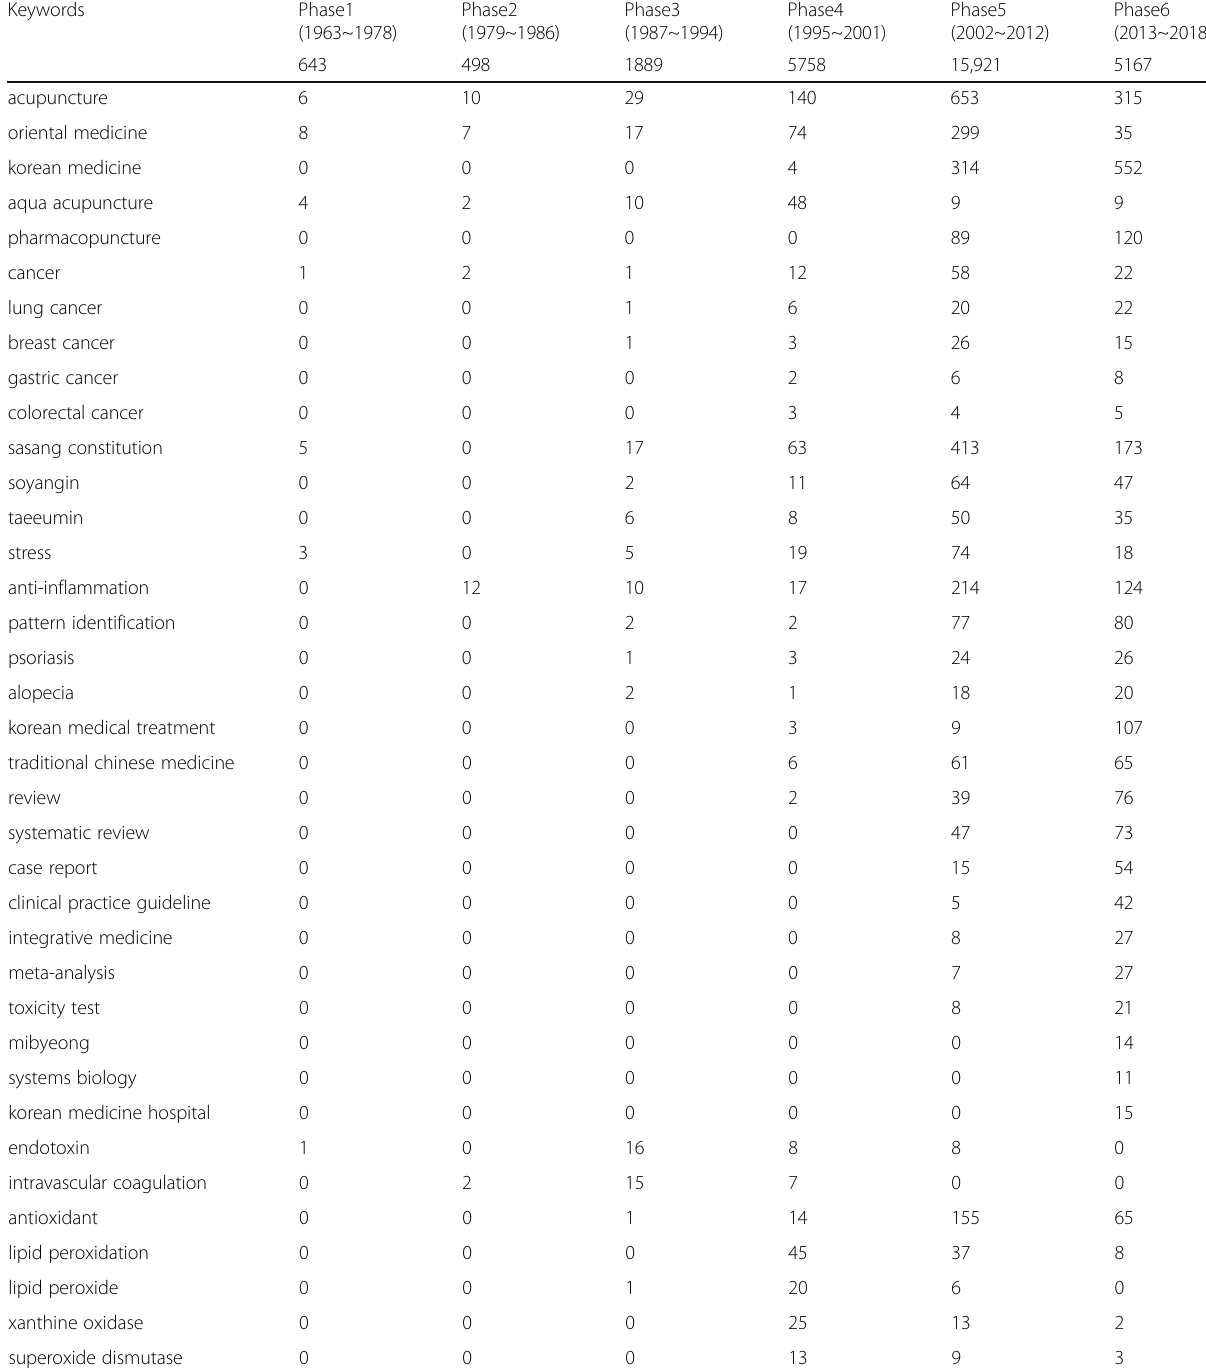
Table 2 Examples of the appearance frequencies of the keywords in each